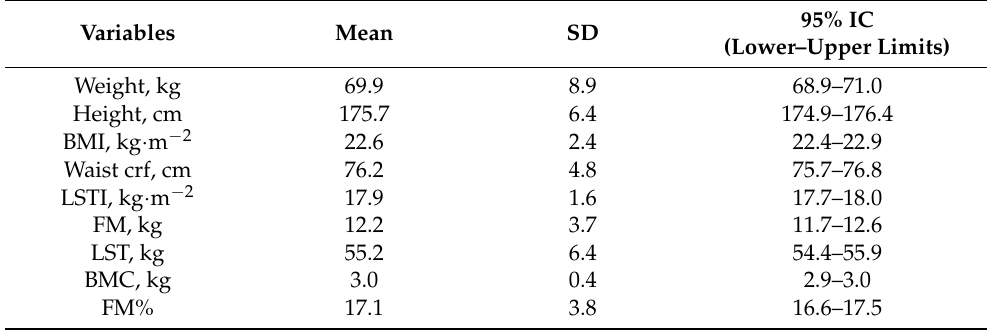
Table 1. Descriptive statistics for body composition of Brazilian Military (N = 270) at the beginning of the routine